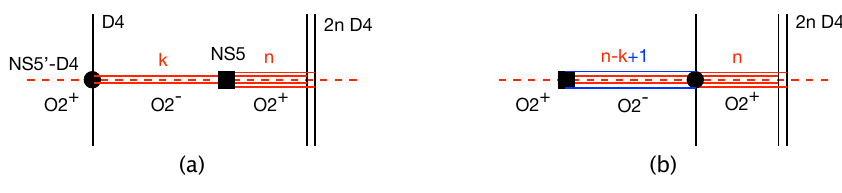
Figure 13 . Duality move in the Type IIA brane con(cid:12)guration for O (2 k ) 0 + 2 n +